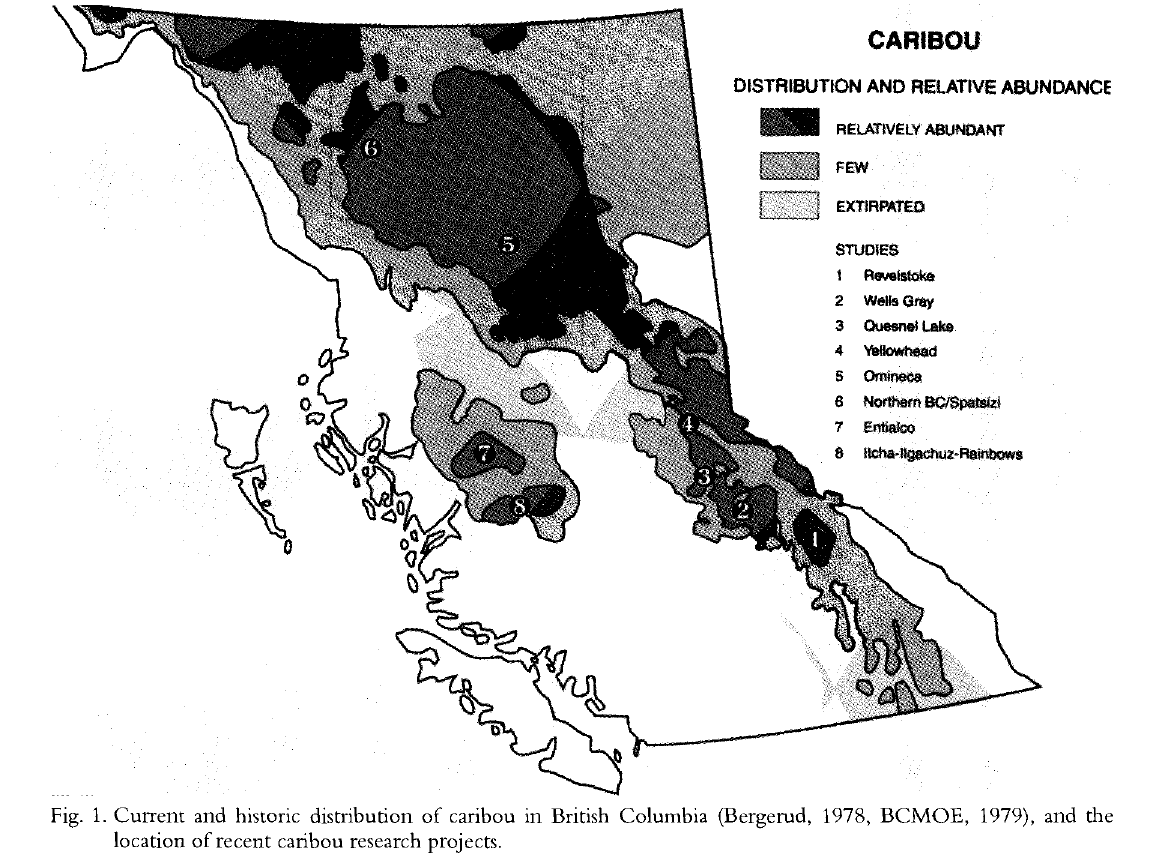
Fig. 1. Current and historic distribution of caribou in British Columbia (Bergerud, 1978, B C M O E, 1979), and the location of recent caribou research